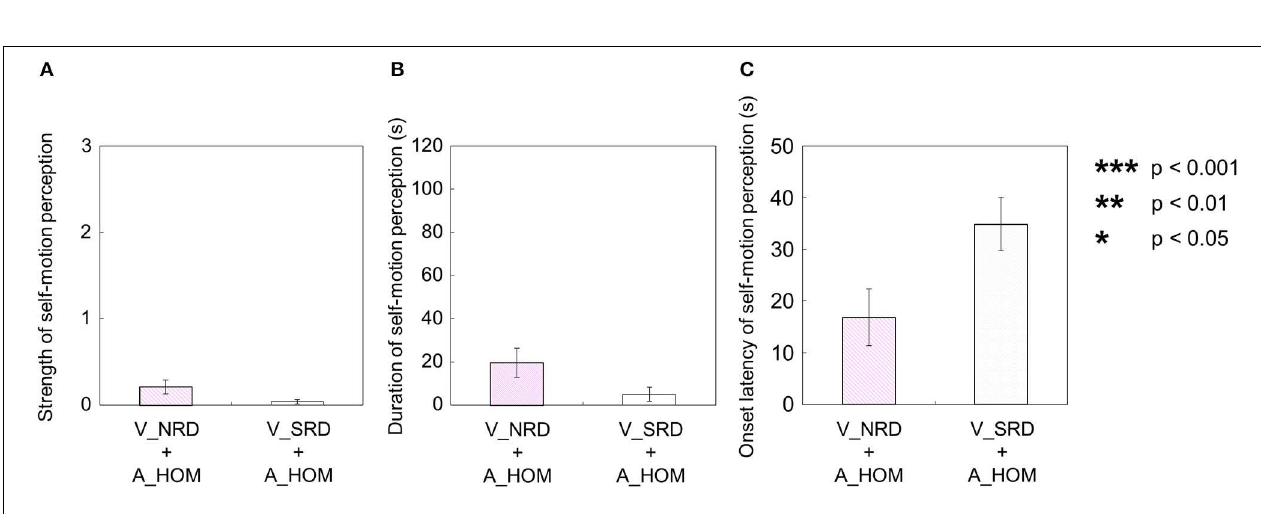
FIGURE 11 | Averaged values of the (A) strength, (B) duration, and (C) onset latency of self-motion perception in the two experimental conditions including one-directional auditory rotation. In each graph, the left bar shows the condition combining no visual stimulus (V_NRD) and